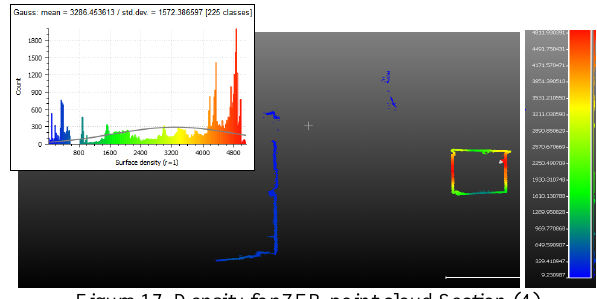
Figure 17. Density for ZEB point cloud Section (4)